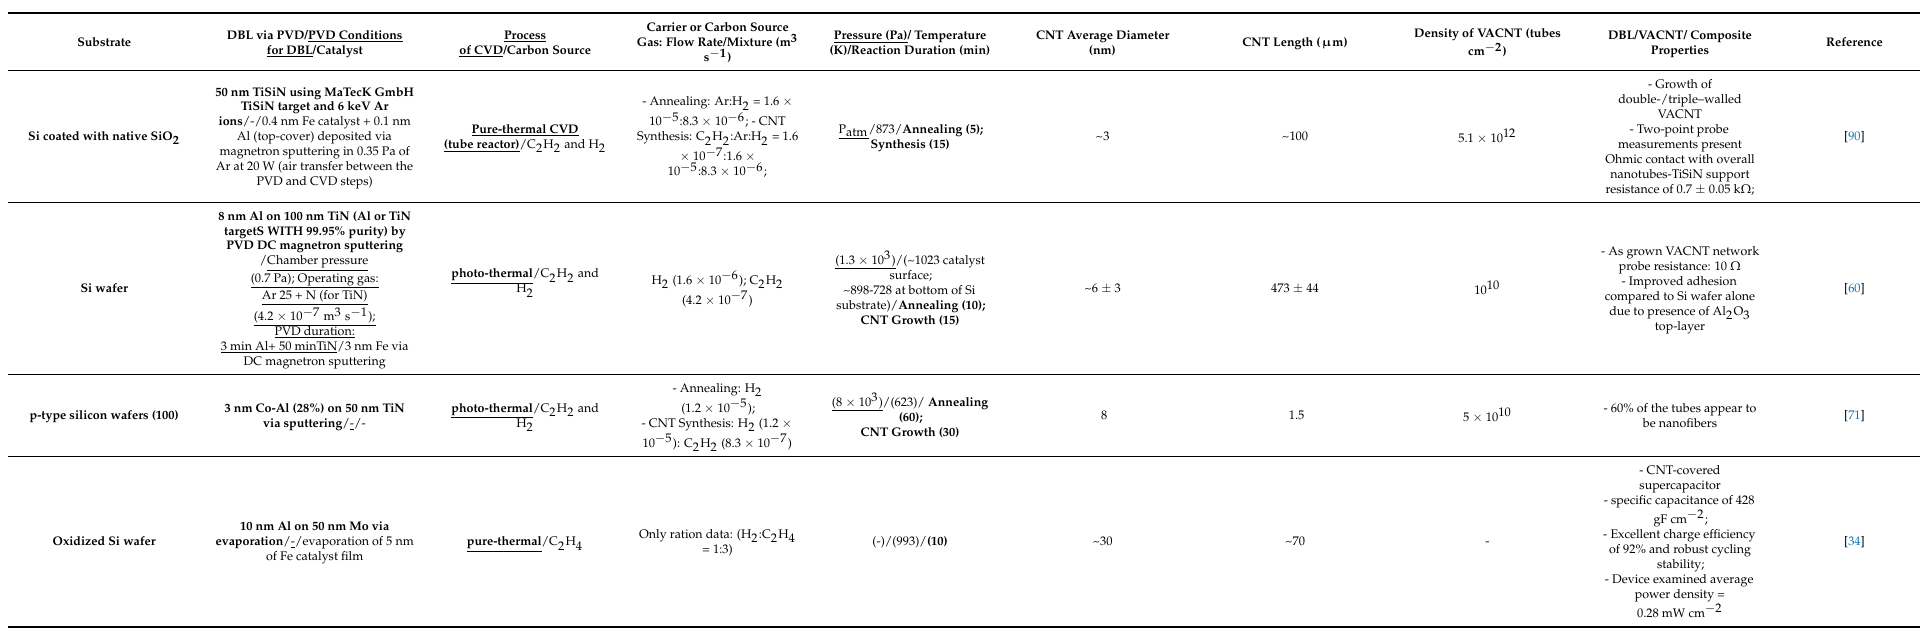
Table 5. Details of used substrate, metal or metal nitrides/silicide-nitrides DBL using Al top-layer (deposited via PVD), and VACNT growth conditions and